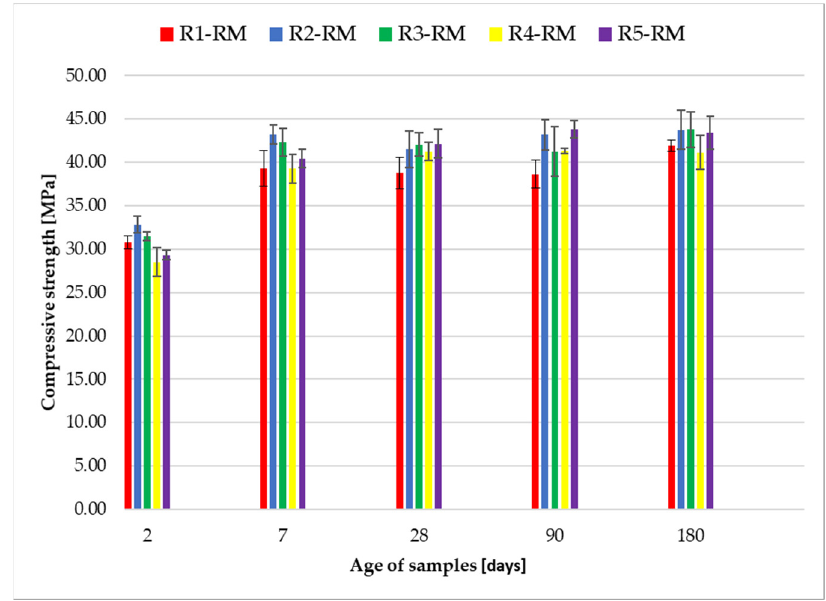
Figure 10. Graphic expression of compressive strength after 2, 7, 28, 90 and 180 days. Table 8. Standard deviation values during the measurements of compressive strength [MPa].